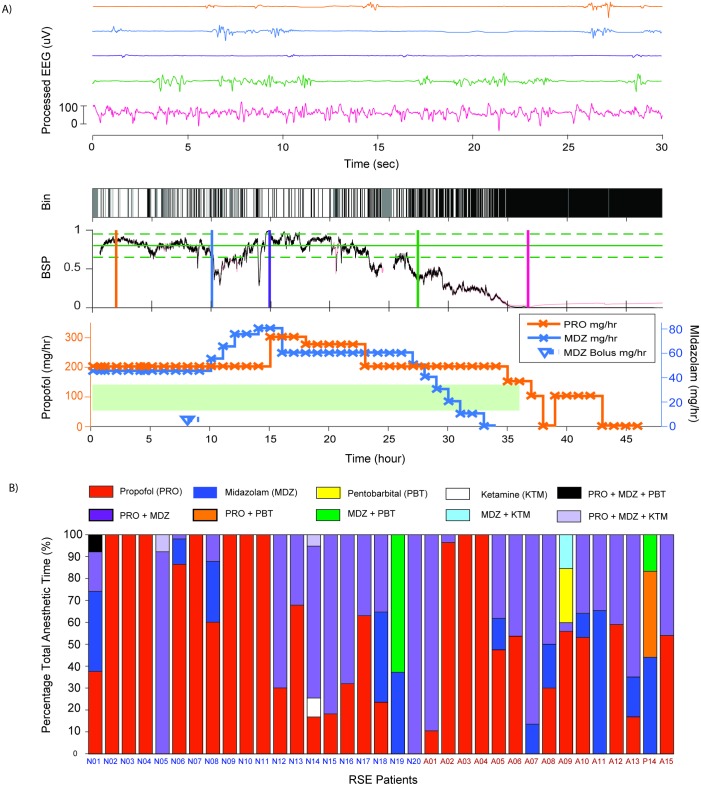
Visual summary of data.A) Example of EEG processing and clinical data collected for one patient. This panel illustrates the correlation made between the EEG and clinical data gathered. (Top) 30-second segments of EEG at selected points of time to illustrate the relationship between the BSP values and the time domain EEG pattern. (Bottom) 48 hours of binary EEG (Bin), BSP and medication used. In the binary EEG plot, suppressions are white and non-suppression periods are black. In the plot of BSP, the target BSP of 0.8 is indicated by the solid green line; the upper and lower bound of the reference range (i.e. BSP 0.65 and BSP 0.95) are indicated by the dashed green line; and the measured BSPs are shown in black. In the medication plot, solid lines show the rates of infusion of IVADs used and hollow markers indicate boluses. Periods with intent to achieve EEG burst suppression are highlighted with a light green bar. B) Overview of all patient profiles and infusion medication used. Percentage of total anesthetic time for each medication or combinations of medications used. Refer to the legend of Table 1 for annotations of abbreviations.